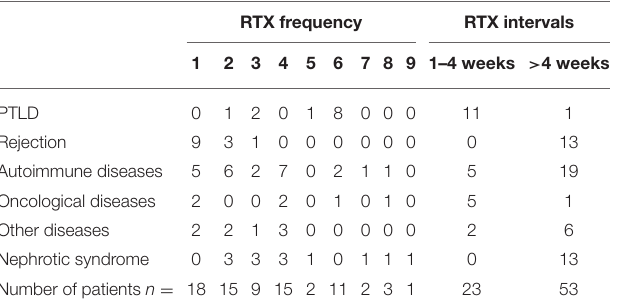
TABLE 2 | RTX frequency and RTX intervals according to underlying disease ( n = 76); PTLD = post-transplant lymphoproliferative disorder. RTX frequency RTX intervals